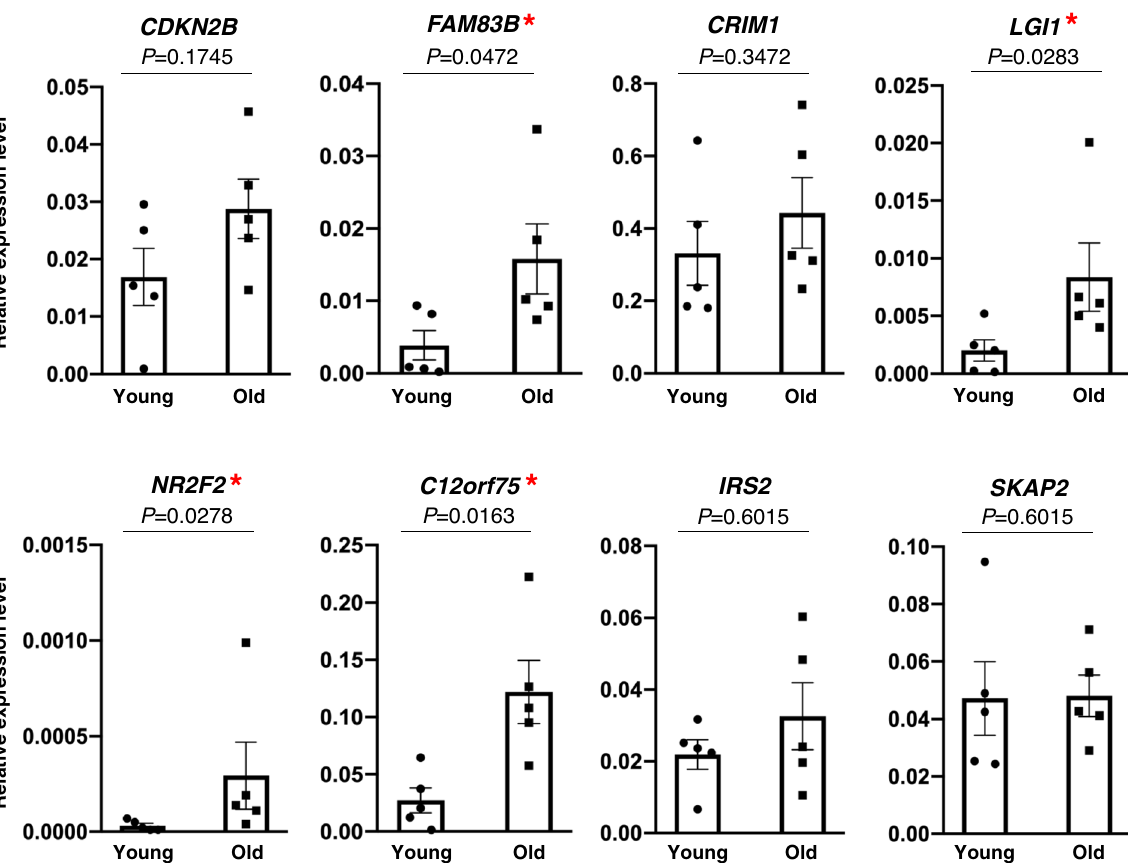
Fig. 4 Validation of RNA (ENSG) expression patterns with age using RT-qPCR analysis. Relative expression levels of fi ve young (20 – 34 years) and fi ve old (65 – 79 years) participants were calculated relative to GAPDH mRNA levels, and were compared using a two-sided Kruskal – Wallis test. Of the eight RNAs selected for analysis, statistically signi fi cant changes in expression with age were identi fi ed for FAM83B ( p = 0.0472), LGI1 ( p = 0.0283), NR2F2 ( p = 0.0278), and C12orf75 ( p = 0.0163) mRNAs, denoted by a red asterisk. All p -values are unadjusted. Error bars represent mean ±